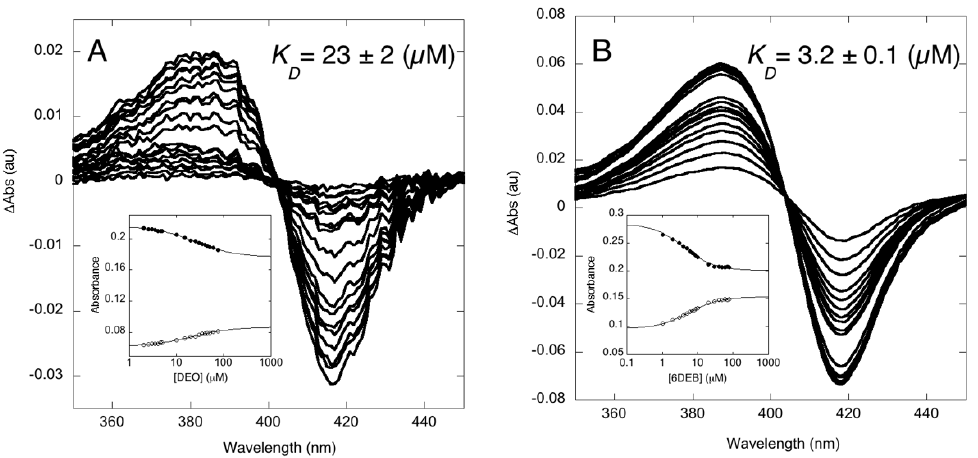
Figure 2. Equilibrium titration of OleP with DEO ( A ) and 6DEB ( B ) at 298 K. Di ff erence spectra and absorbance intensities (relative inset) of OleP as function of total DEO and 6DEB concentration are reported. Data refer to the absorbance monitored at 417 nm (full dots) and at 382 nm for DEO and 388 nm for 6DEB (empty dots) at a constant concentration of OleP in 50 mM Hepes and 200 mM NaCl, pH 7.5. Lines are the best fit to hyperbolic functions.